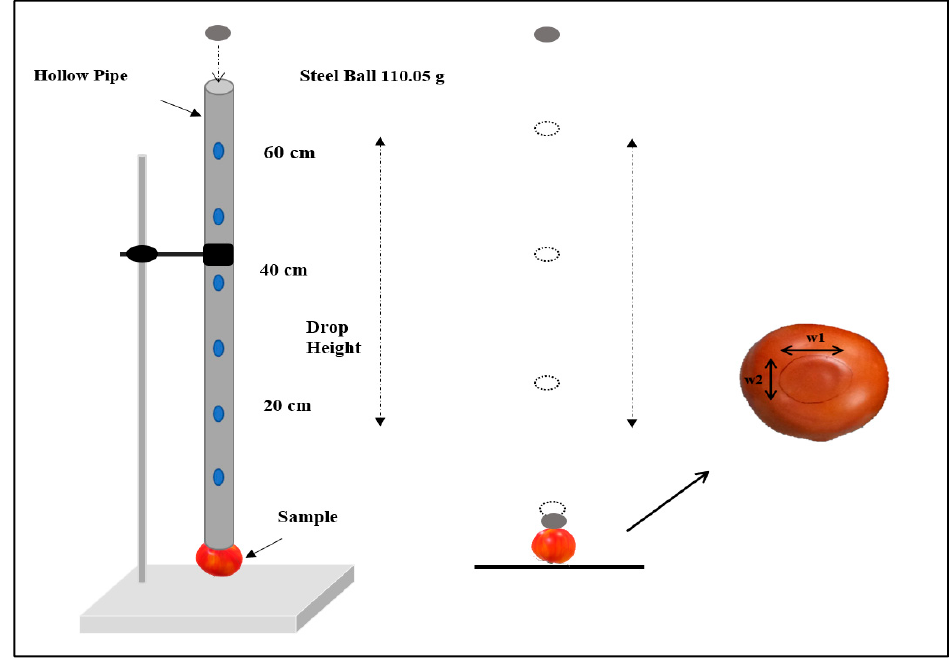
Figure 1. Schematic experimental setup. w 1 and w 2 are major and minor widths (diameter). Based on Equation (1), the impact energy ( Ei , mJ) resulting from each drop height was 215.91 mJ, 431.83 mJ, and 647.75 mJ for low, medium, and high impact levels, respec- tively [7].